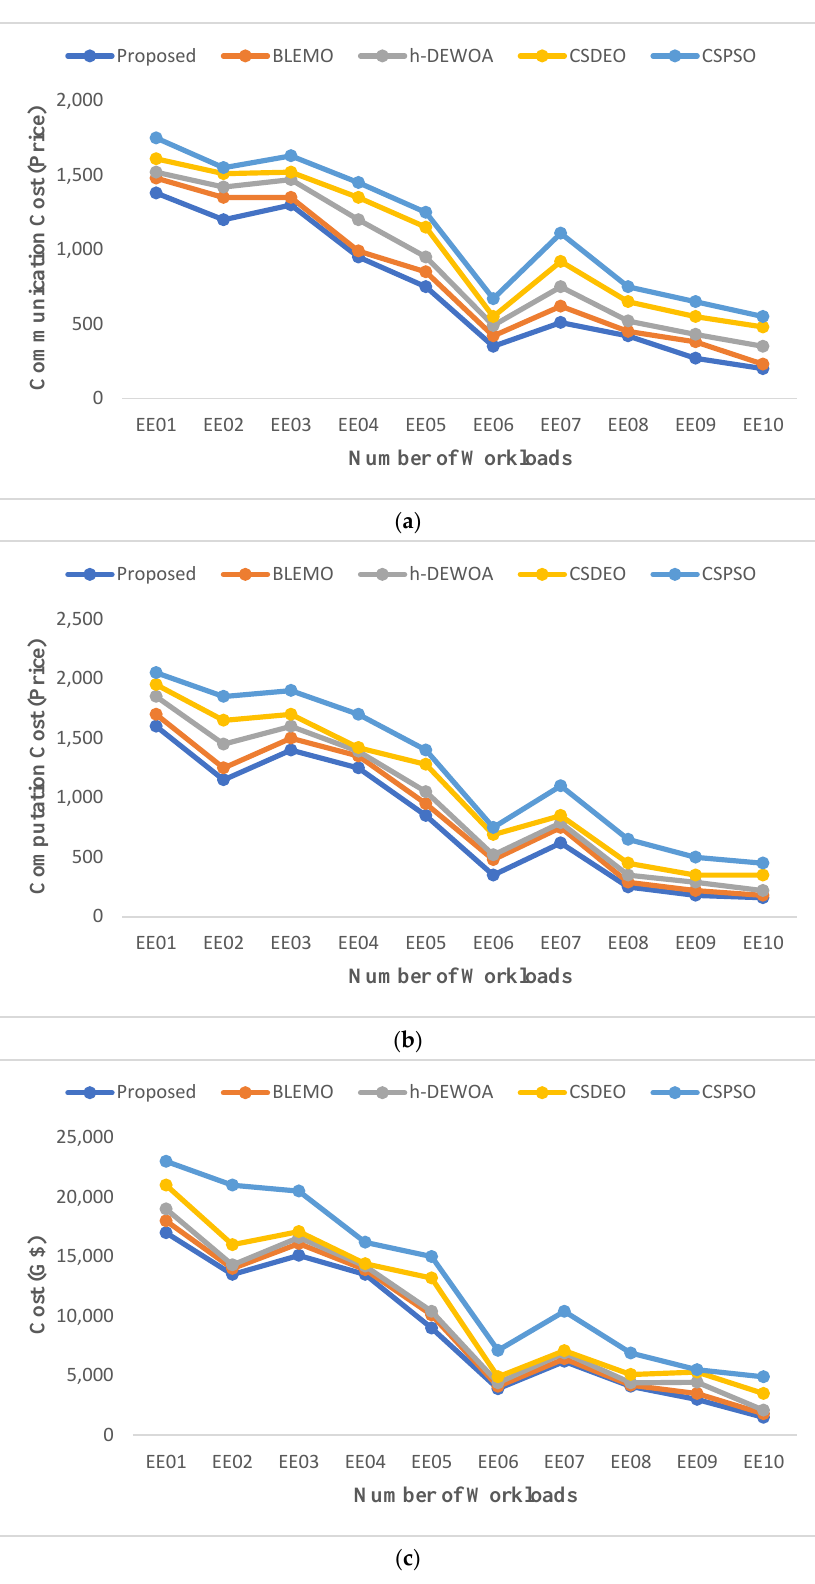
Figure 8. Comparison of ( a ) communication cost, ( b ) computation cost, and ( c ) total cost of HPC2N